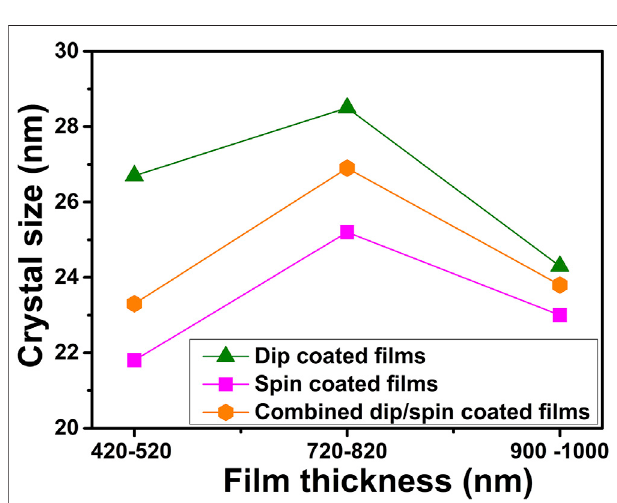
FIGURE 5 | The crystal size of α -Fe 2 O 3 fi lms of various thickness ranges prepared using different coating techniques.